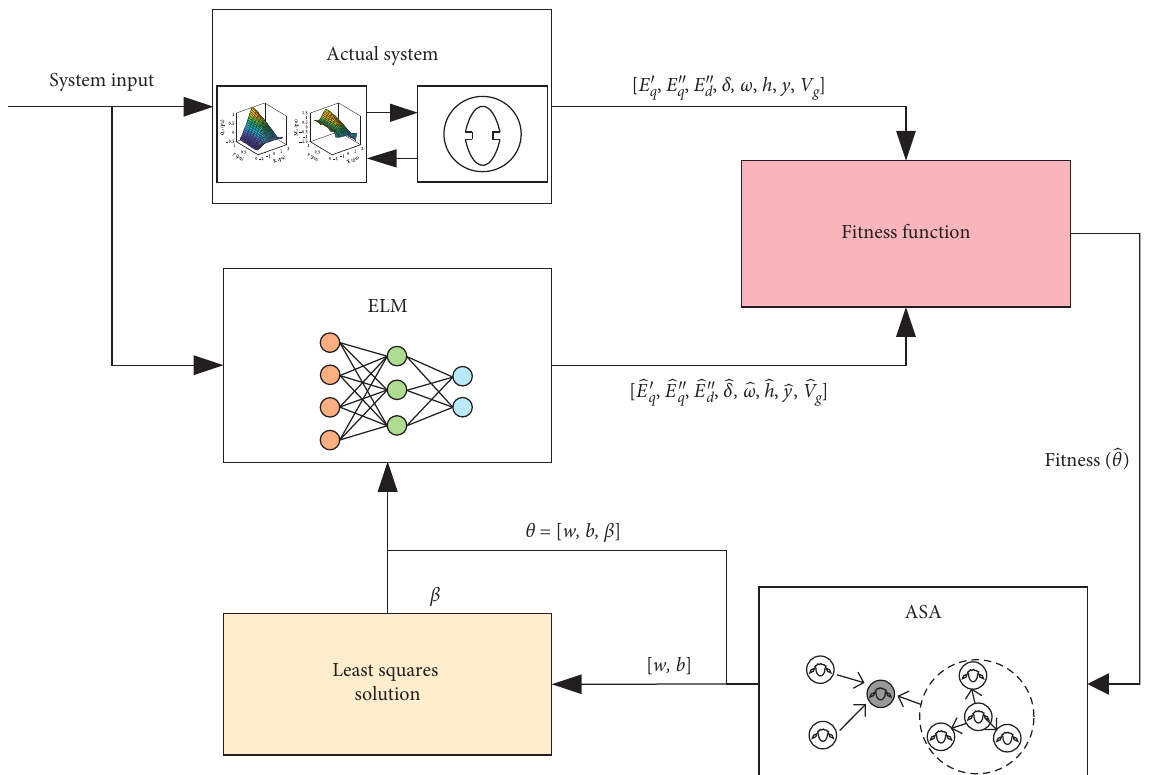
Figure 11: The general structure of the prior-knowledge learning for WOS-ELM based on